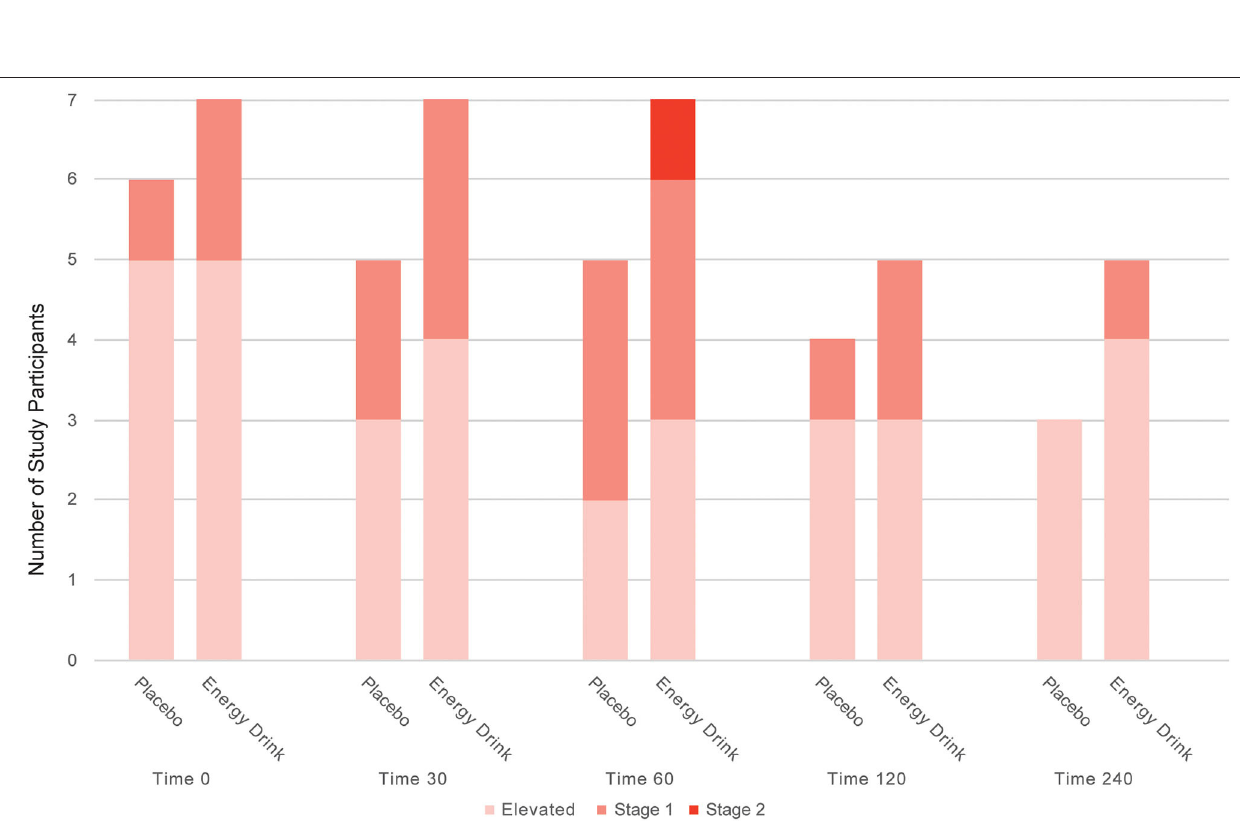
Frontiers in Cardiovascular Medicine |